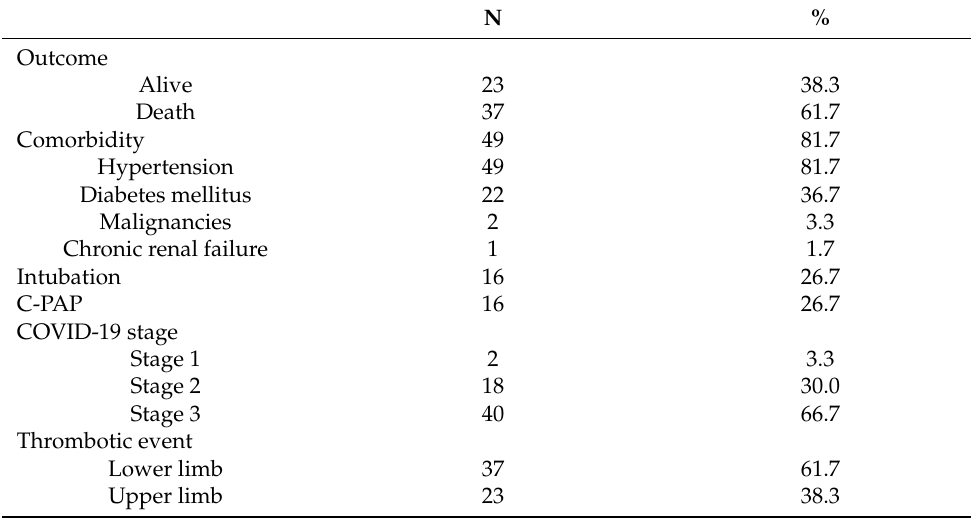
Table 2. Clinical profile of patients.